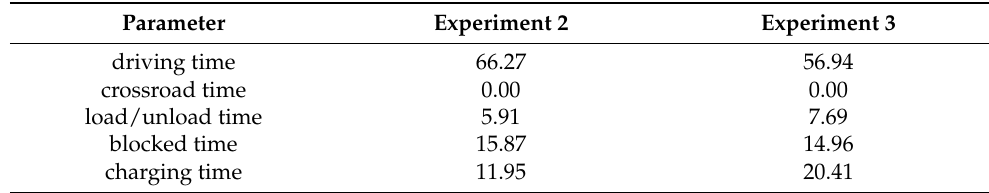
Table 1. Results of